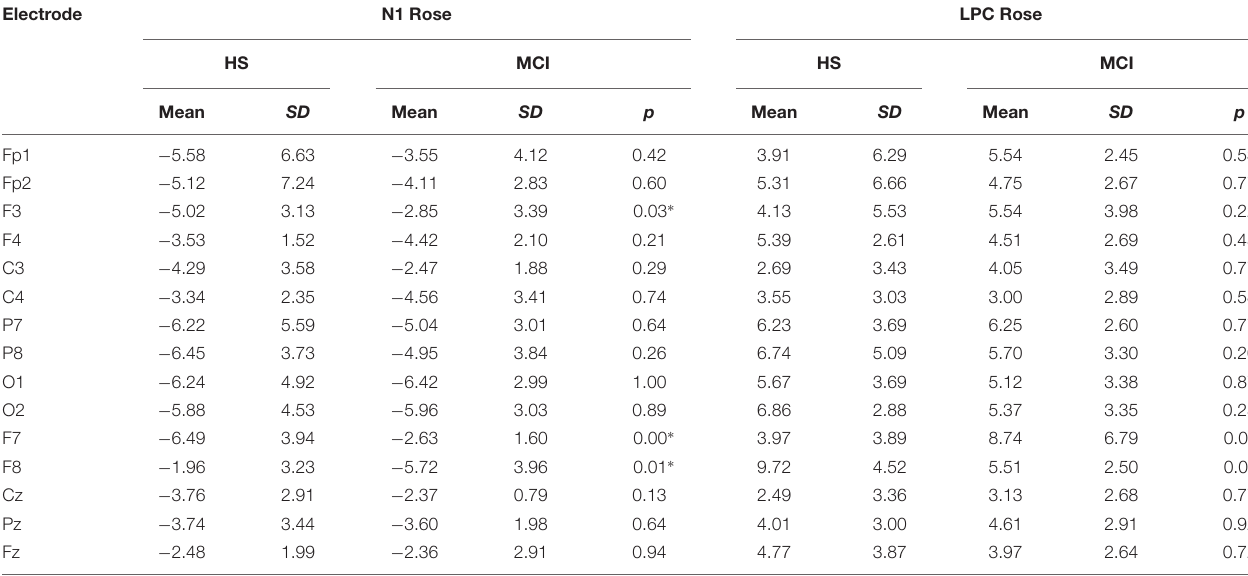
SD, standard deviation; p, p-value.